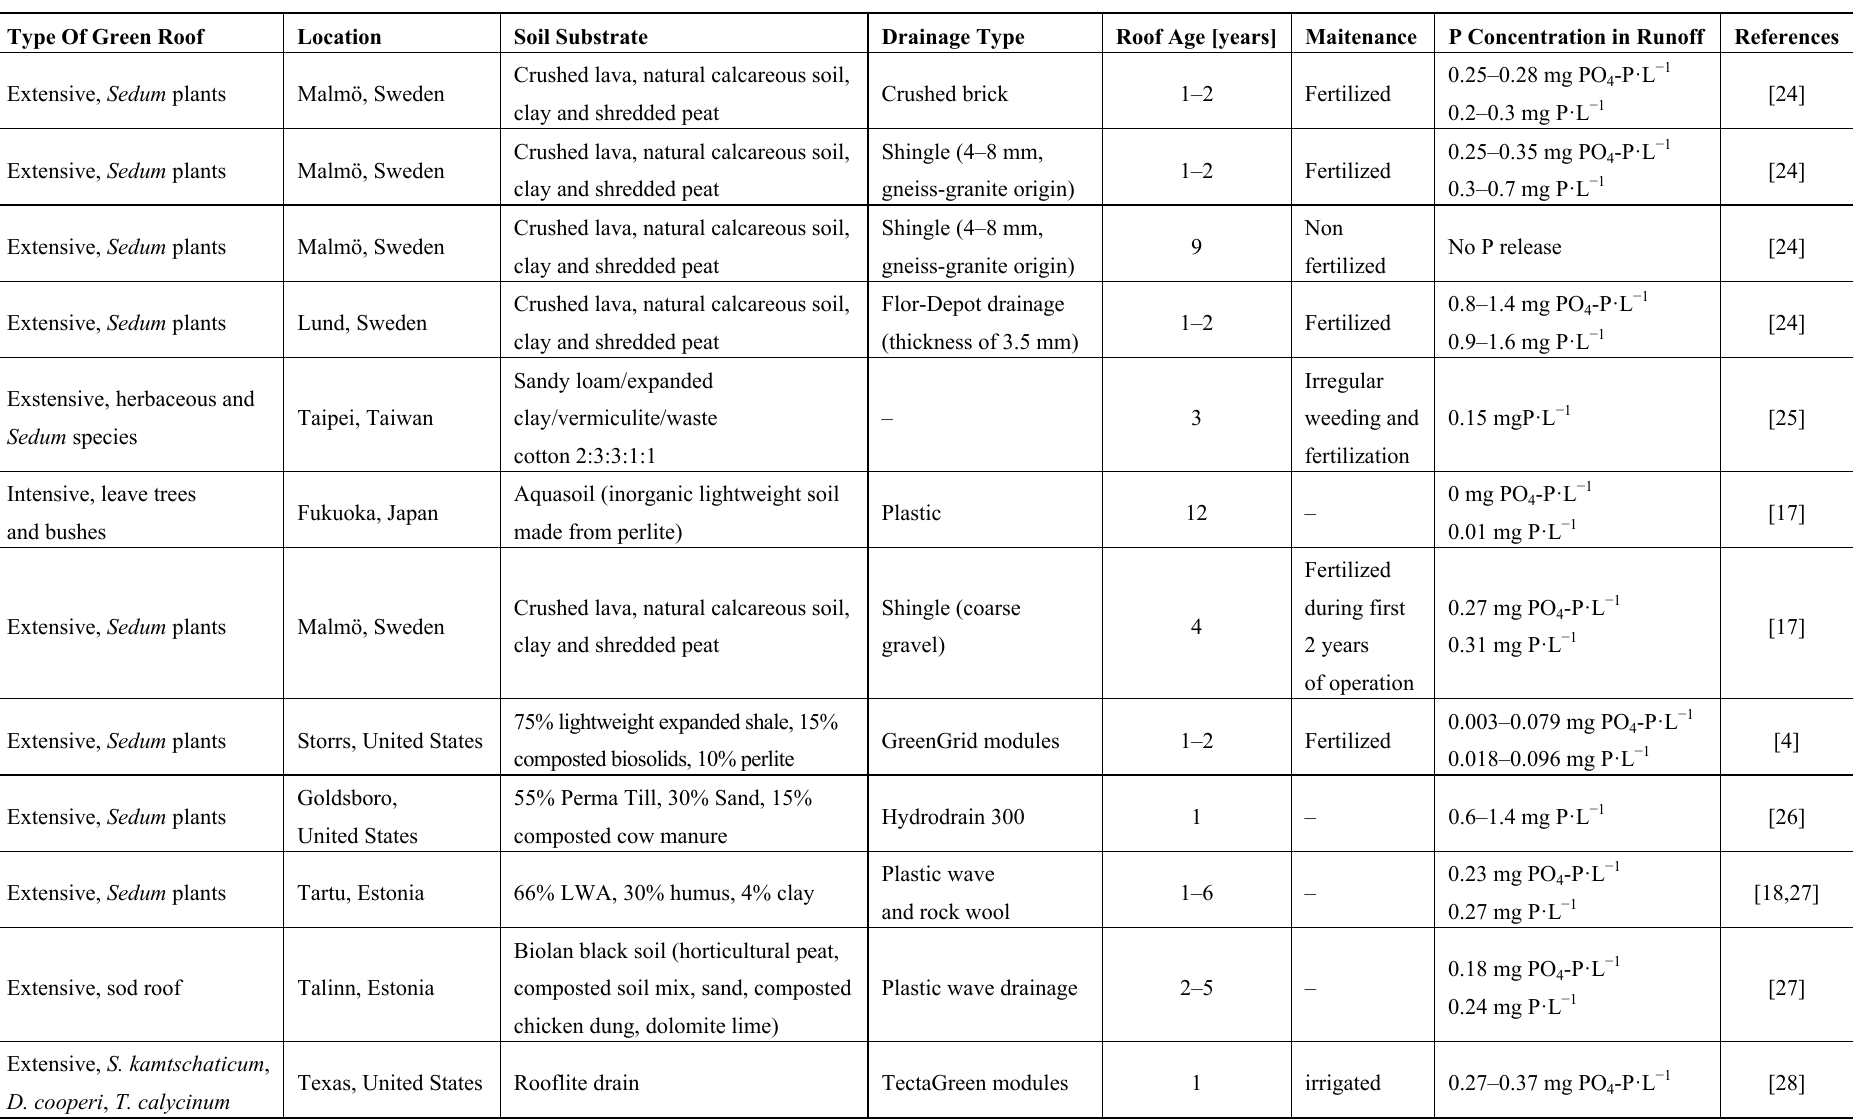
Table 2. Phosphorus found in runoff from green roofs—literature